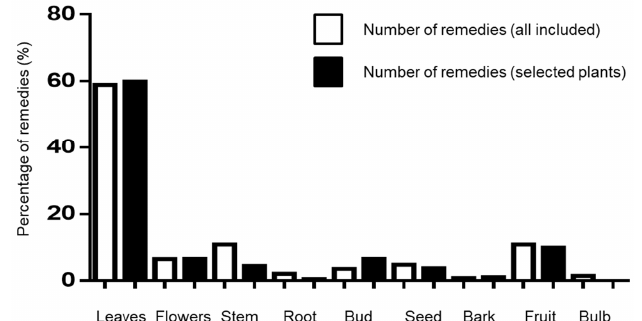
Figure 5. Plant-based remedies in the ethnopharmacological survey. Percentage of remedies using different plant parts for 523 initials remedies involving only the 22 plants selected.